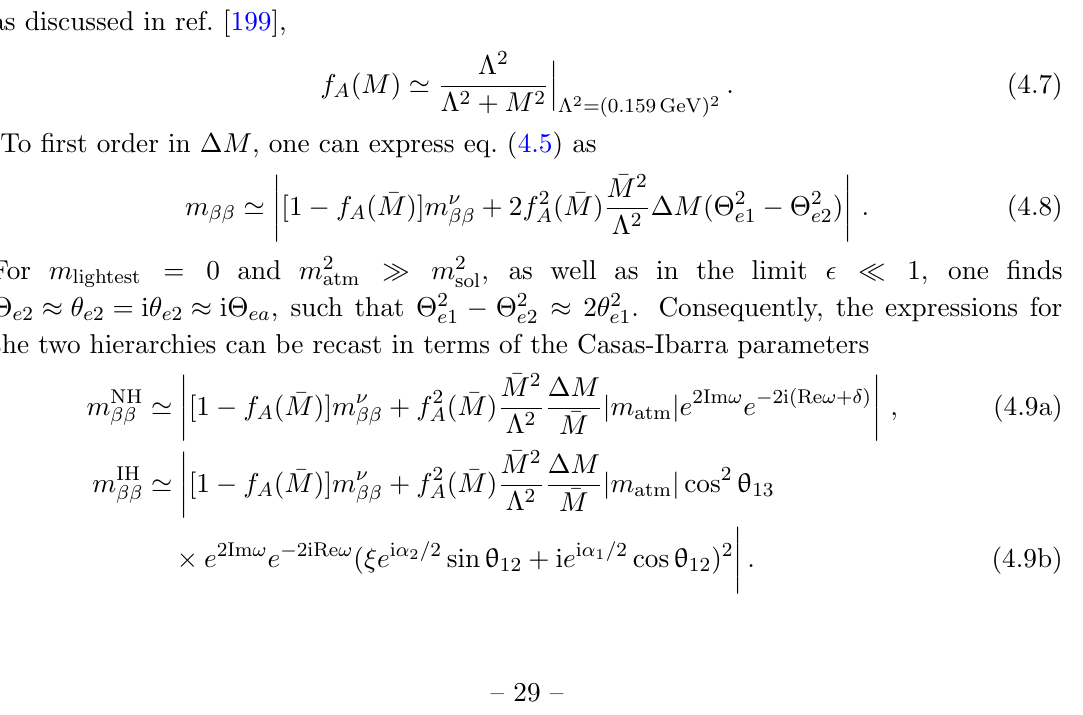
=U 2 is given by the requirement P (cid:28)